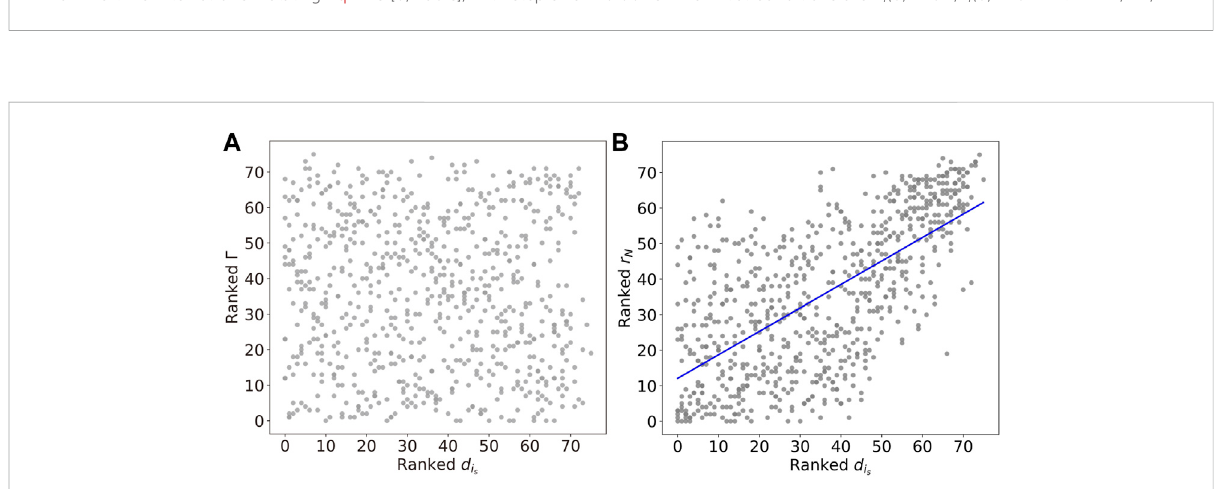
FIGURE 10 (A) The linear relations between the Kuramoto order parameter r N and degree d i 2.55 × 10 − 94 . The blue line represents the best- fi t line. (B) The chimera index Γ shows no apparent correlation with d i s